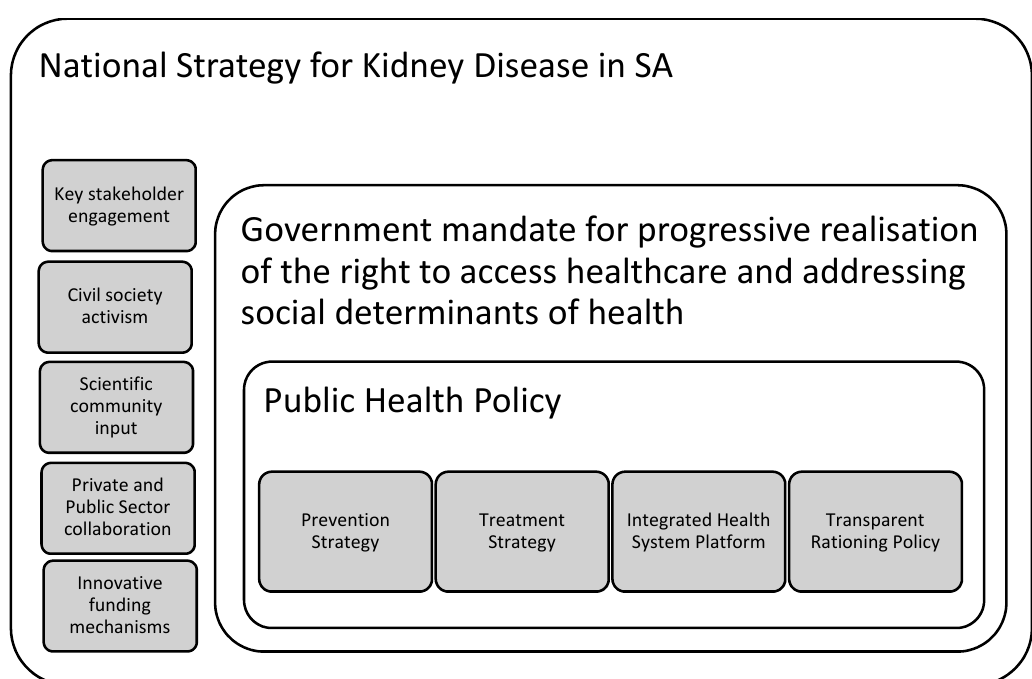
Figure 4. National strategy for kidney disease.